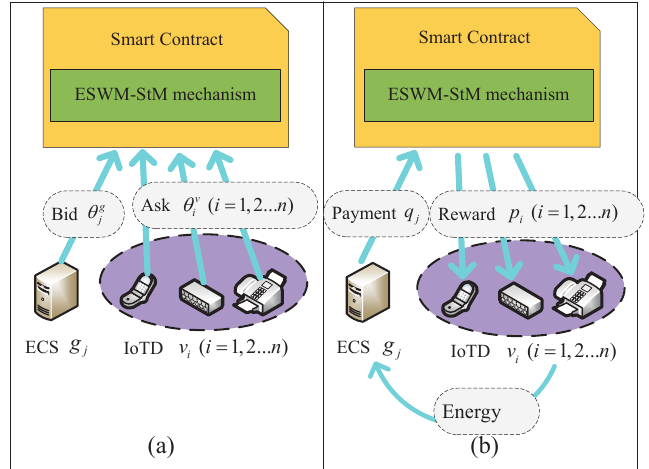
Figure 2. Double auction mechanism based on smart